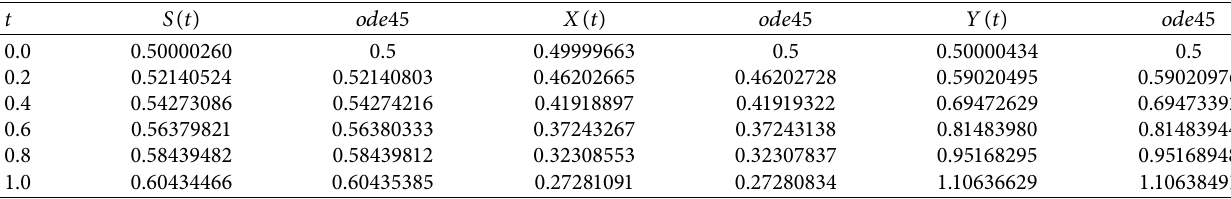
Table 28: Approximate solutions obtained by the LeNN-WOA-NM algorithm for population densities of local prey, immigrant prey, and predator under the influence of the negative impact of the force of interaction on immigrant prey β